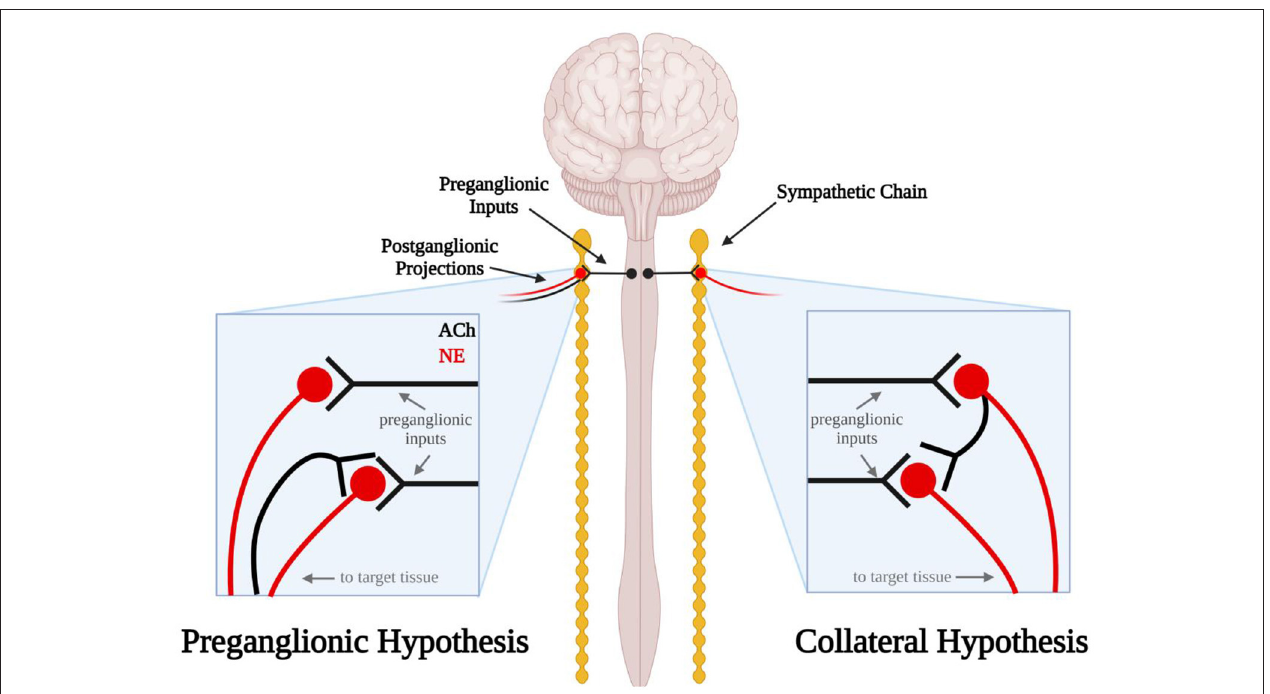
FIGURE 1 | Schematic diagram illustrating the errant preganglionic fiber and collateral hypotheses. In the preganglionic hypothesis (left), mis-routed cholinergic (black) preganglionic fibers travel back up the efferent nerves through which sympathetic axons travel to the target tissue. In the collateral hypothesis (right) postganglionic sympathetic neurons send noradrenergic projections (red) to the target tissue and cholinergic projections (black) to other sympathetic neurons in the sympathetic chain